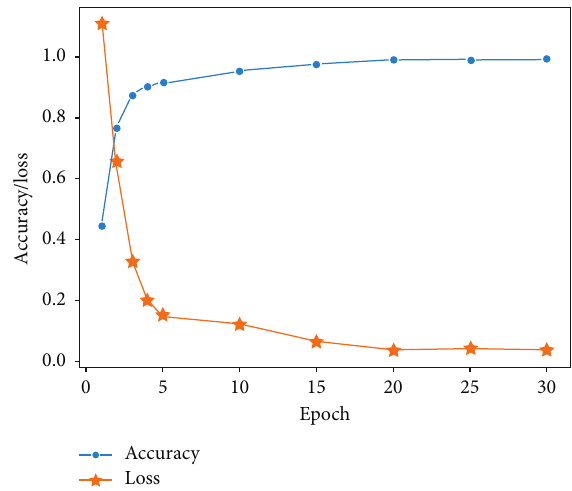
Figure 8: Training result of generalization ability research.